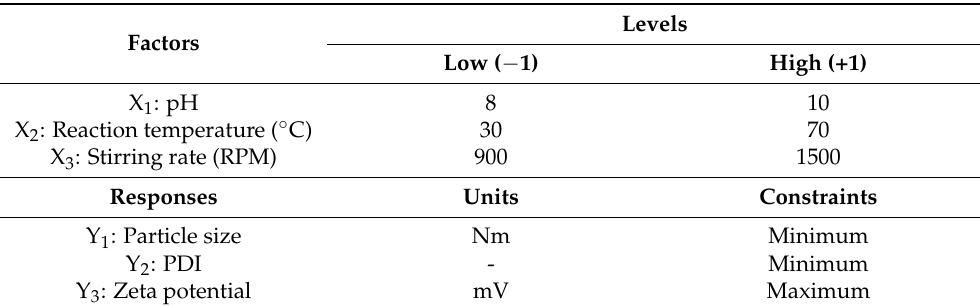
Table 1. Factors and levels that affected the particle size, polydispersity, and surface charge of